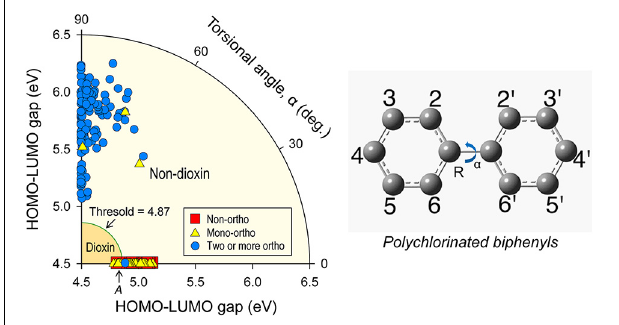
FIGURE 1 | HOMO-LUMO gap of PCB congeners. Calculated HOMO-LUMO gap of all PCB congeners differentiated by number of ortho -chlorination sites. Below threshold of 4.87eV are the 12 dioxin-like PCBs, above the threshold are non-dioxins. Note that coplanar PCBs have (on average) lesser band-gaps. PCB-74 (denote as A ) is considered a possible dioxin, due to its band-gap below the threshold. Torsional angle, α is defined as “twist” around center axis, as depicted in